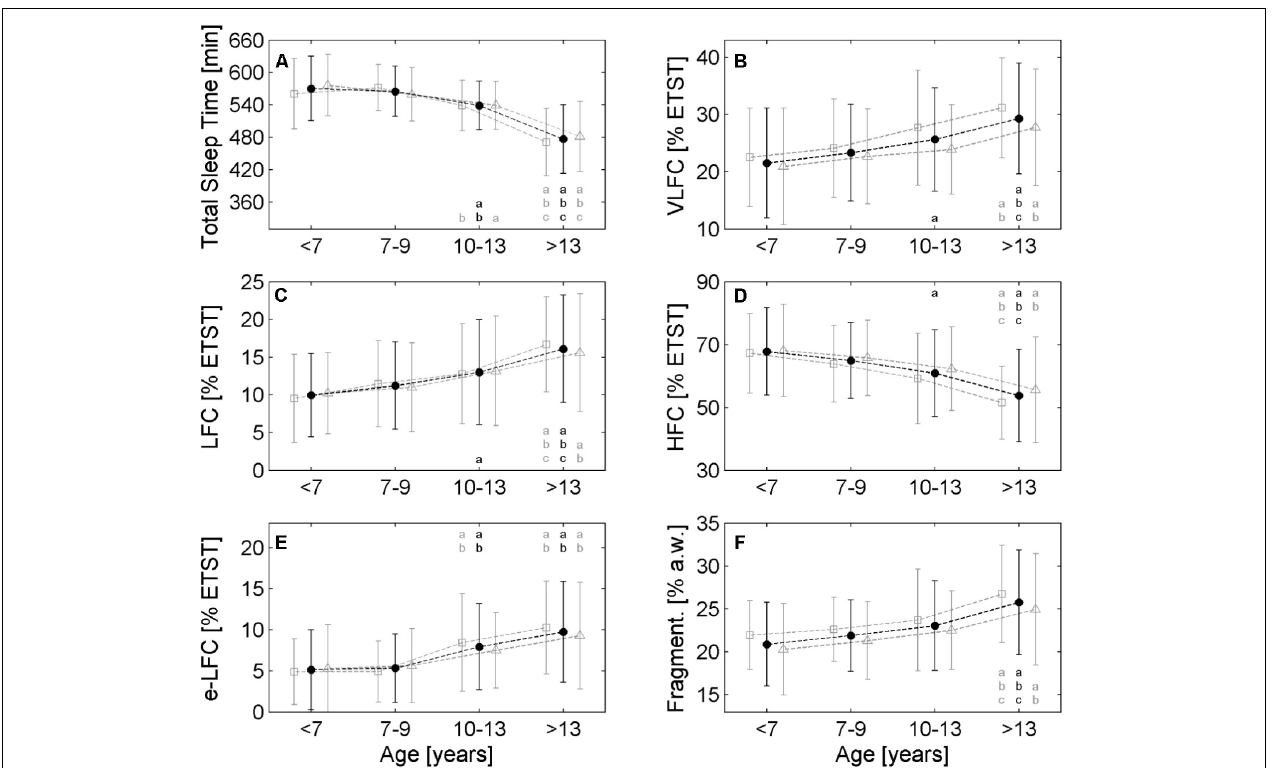
FIGURE 2 | Comparison of different age groups with respect to the cardiopulmonary coupling (CPC) parameters. (A) Estimated total sleep time (ETST), (B) Very low frequency coupling (VLFC) indicating REM/wake states, (C) Low Frequency Coupling (LFC) indicating unstable non-REM sleep, i.e., cyclic alternating pattern (CAP) sleep, (D) High Frequency Coupling (HFC) indicating stable non-REM sleep, i.e., non-CAP sleep, (E) Elevated low frequency coupling (e-LFC) indicating disordered breathing and (F) fragmentation of sleep. Each age group shows three values: the average of the entire group is plotted in the middle (black points), open squares on the left of each black point show the average of male subjects and open triangles show the average of female subjects. The small letters in each diagram refer to significant differences ( p < 0.05) with respect to the following age group: a: < 7 years, b: 7–9 years, c: 10–13 years. Black letters refer to the whole group, gray letters on the left and right of the black letter denote males and females,